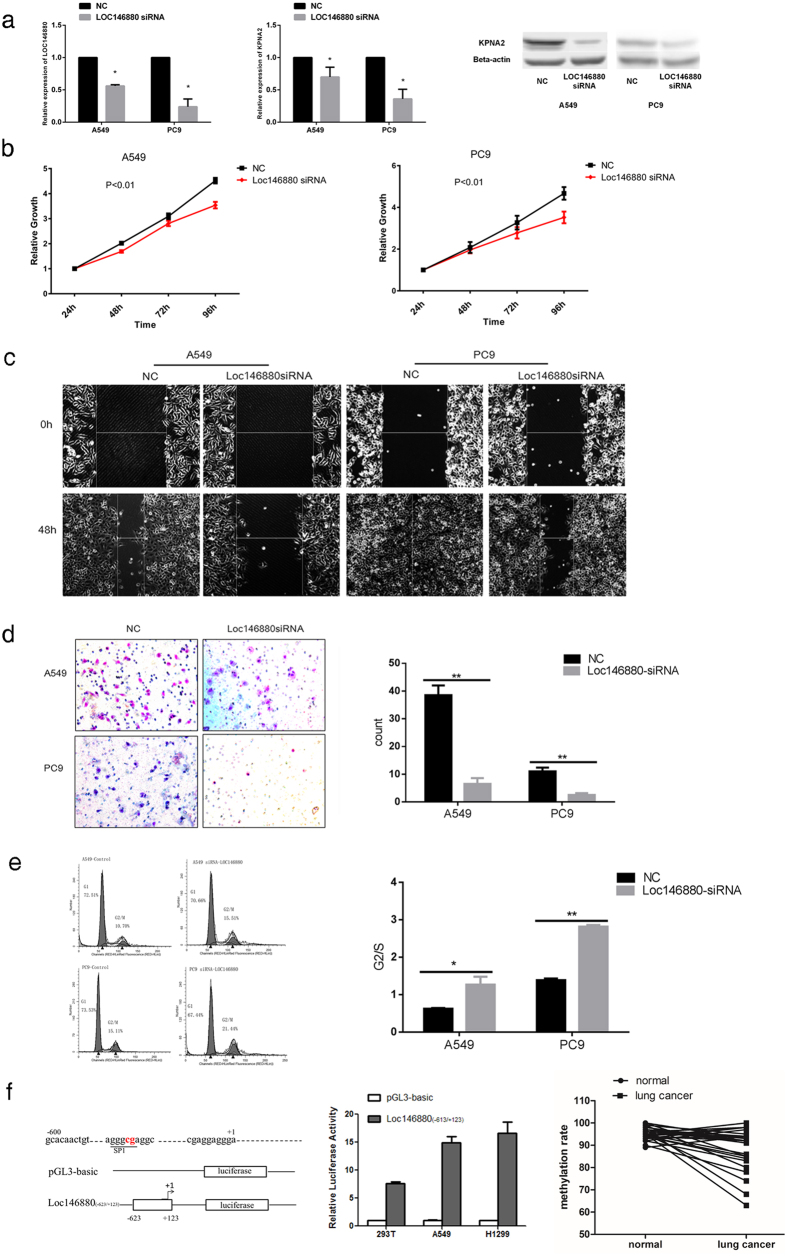
Functional analysis of LOC146880 expression in NSCLC cell lines.(a) Declined expression of LOC146880 and KPNA2 after siRNA-LOC146880 transfection. Declined expression of KPNA2 proteins after siRNA-LOC146880 transfection. (b) Declined A549/PC9 cell proliferation after lowering the expression of LOC146880. (c) Declined A549/PC9 cell migration after lowering the expression of LOC146880. (d) Declined A549/PC9 cell invasion after lowering the expression of LOC147880. (e) Reduced cell cycle progression measured by the C6 flow cytometry after lowering the expression of LOC146880. (f) A promoter region of LOC146880 contains a CpG site which was predicted to be a transcription factor SP1 binding site. A LOC146880 fragment (−623/+123) was cloned into the pGL3-basic vector. The vector containing the LOC146880 (−623/+123) construct displayed 15-fold increases in promoter activities compared with the PGL3-basic vector. LOC146880 methylation is lower in tumors than in normal tissues. Data are expressed as mean ± s.d.; *P < 0.05, **P < 0.01. NC, Negative Control.